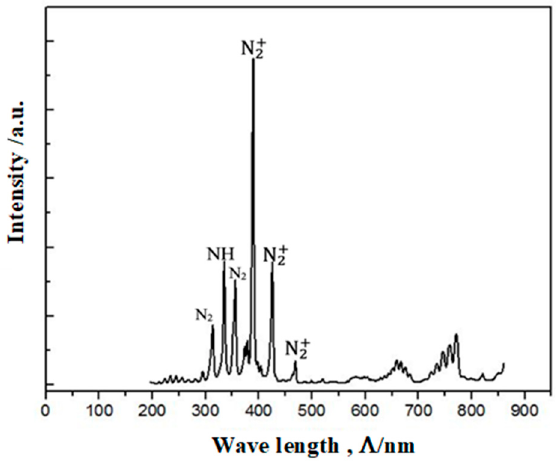
Figure 2. A typical spectrum of N 2 + H 2 plasmas by OES.